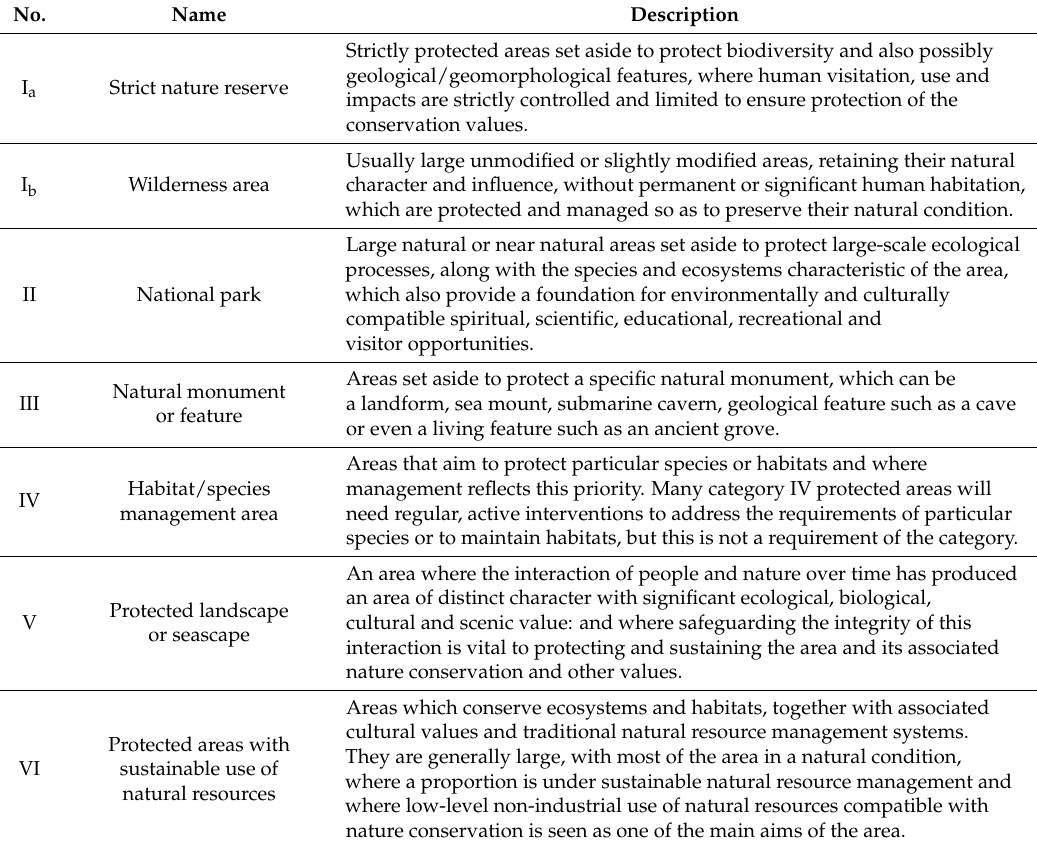
Table 1. The International Union for Conservation of Nature (IUCN) Protected Area Management Categories. Source: Dudley, 2008